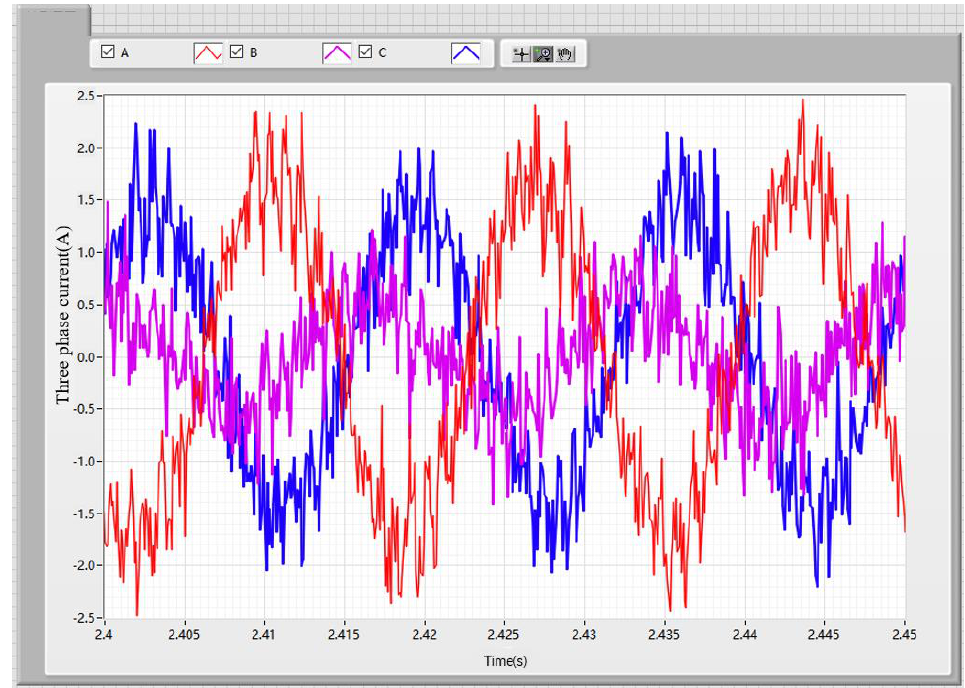
Figure 16. Sampling waveform of a motor three − phase current in a severe turn − to − turn short circuit state.